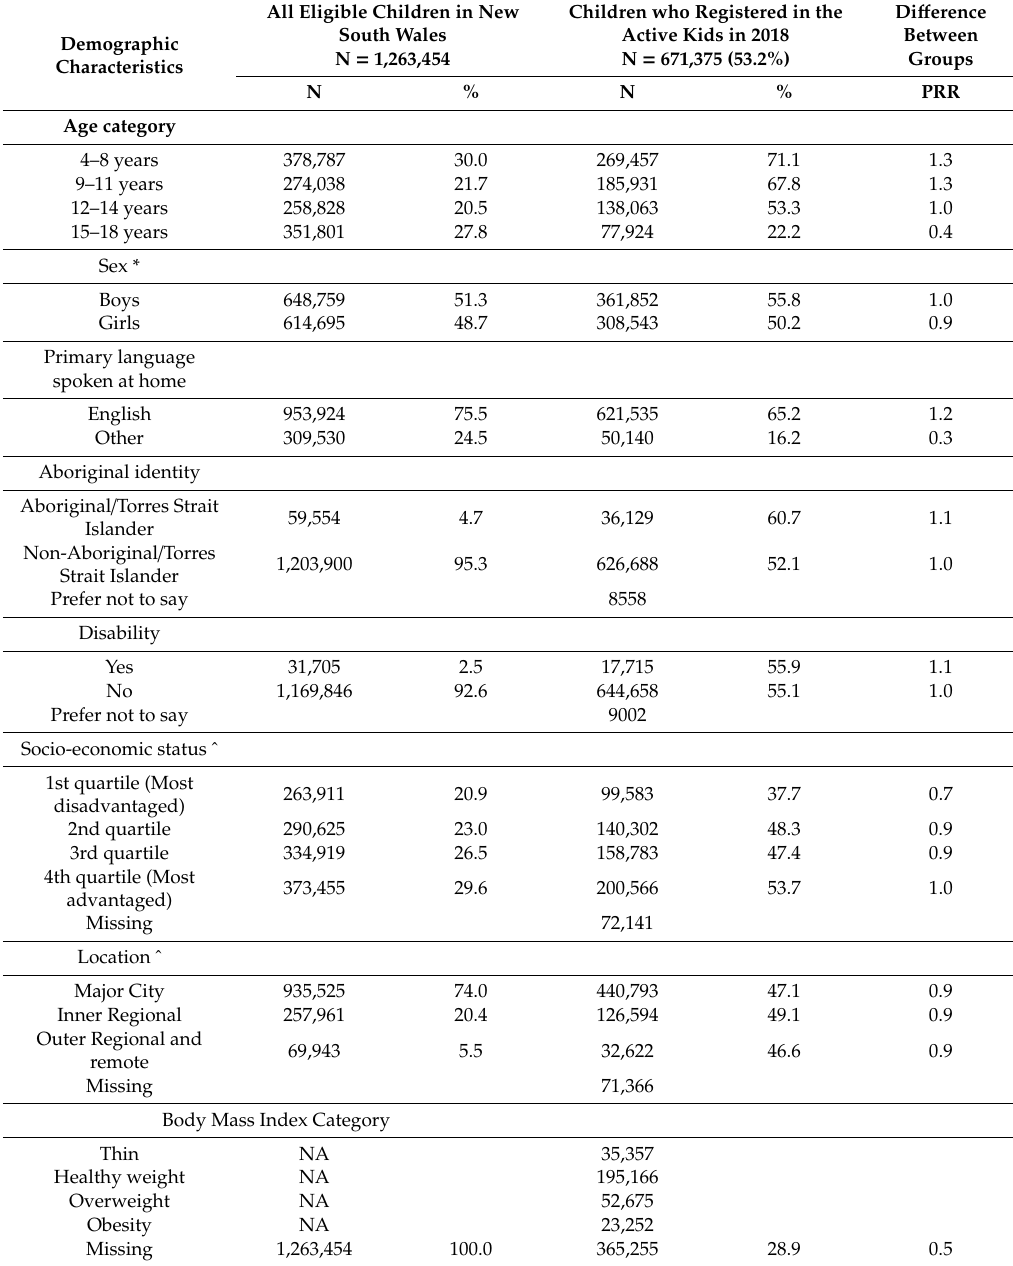
Table 1. Reach of the Active Kids program in New South